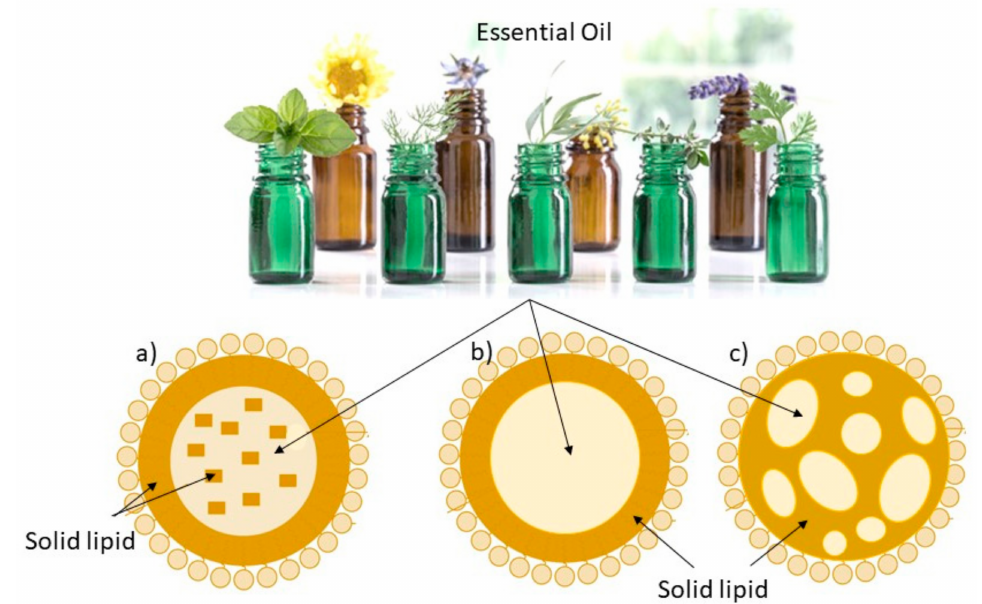
Figure 6. EOs delivery into solid lipid nanoparticles (SLN) ( a ) or nanostructured lipid carriers (NLC) of different types, depending on the formation of a single ( b ) or different nanocompartments of oil ( c